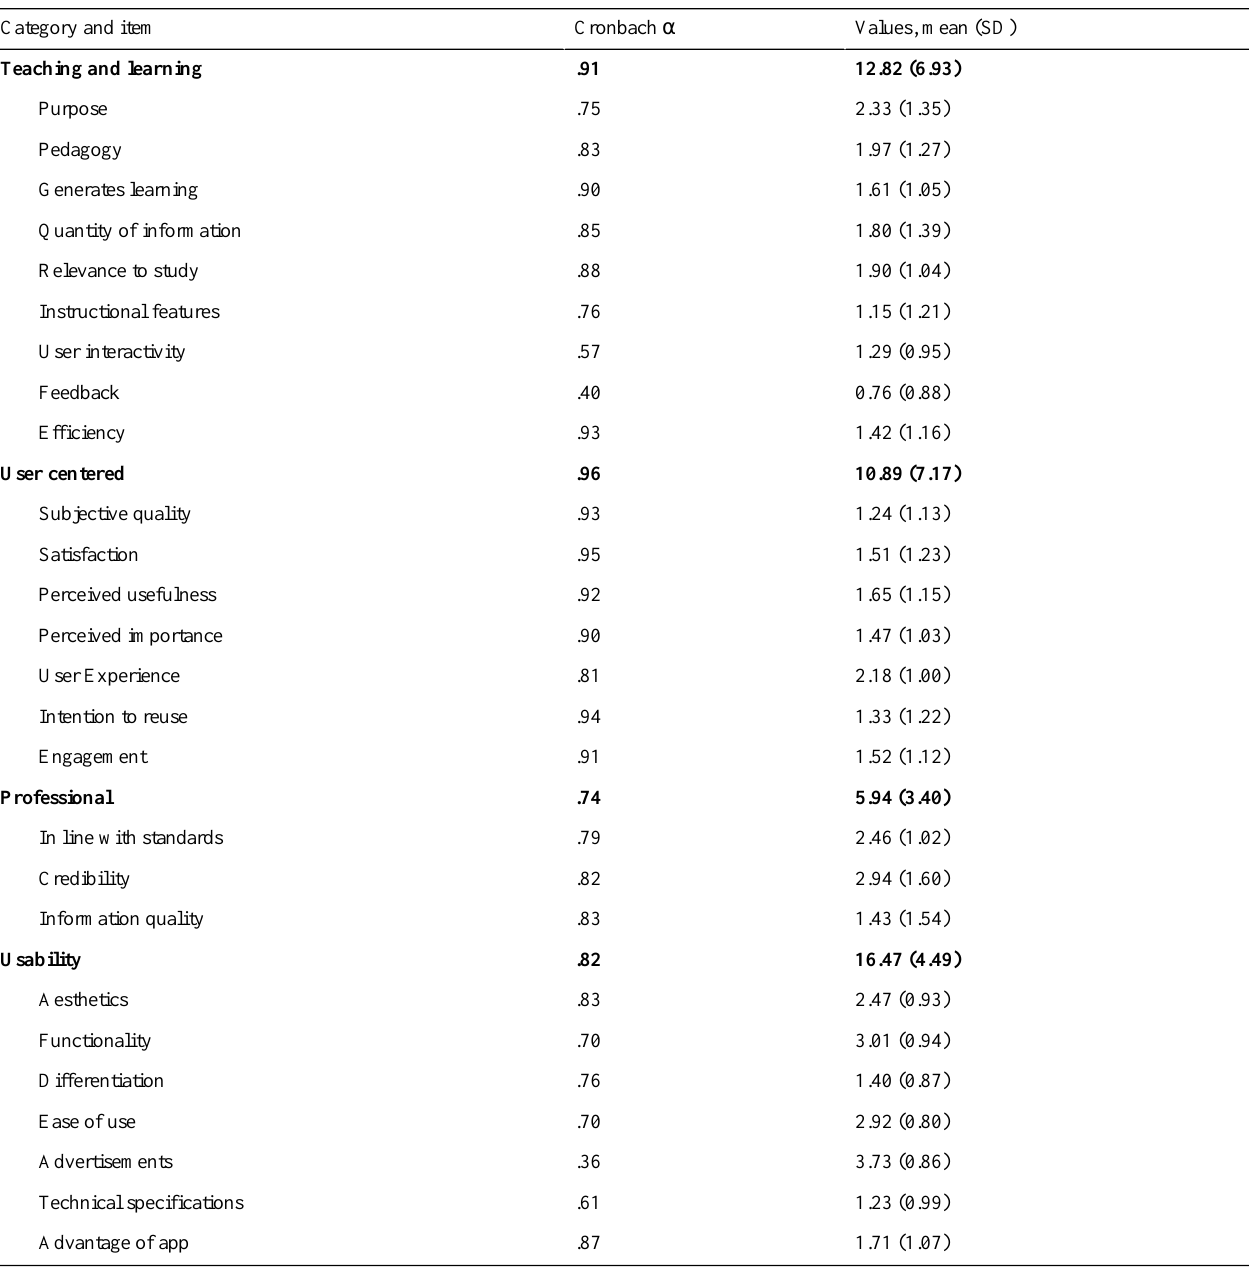
Table 3. Item statistics by category for final version of the Mobile App Rubric for